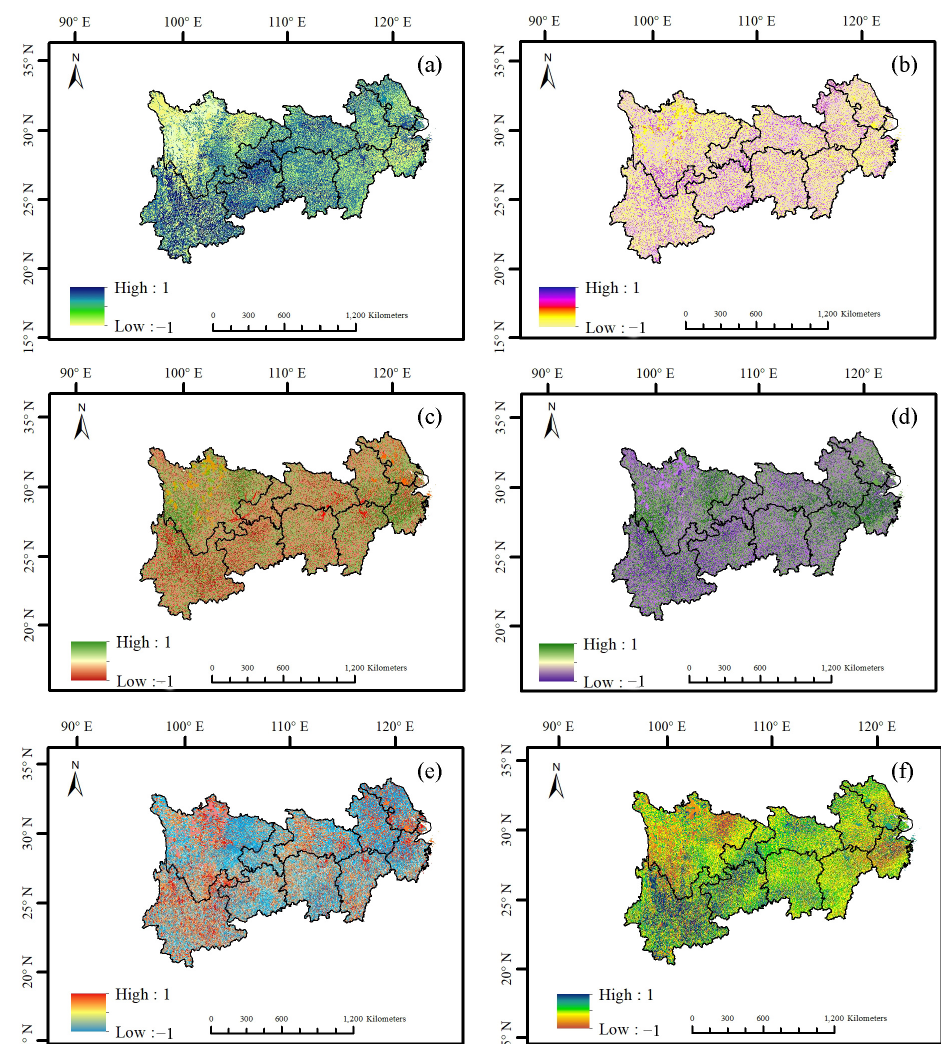
Figure 7. Spatial distribution of the correlation between human activities and ESV in the YREB from 1999 to 2018 (( a ): water yield; ( b ): soil retention; ( c ): water purification-nitrogen; ( d ): water purification-phosphorus; ( e ): NPP; ( f ): integrated